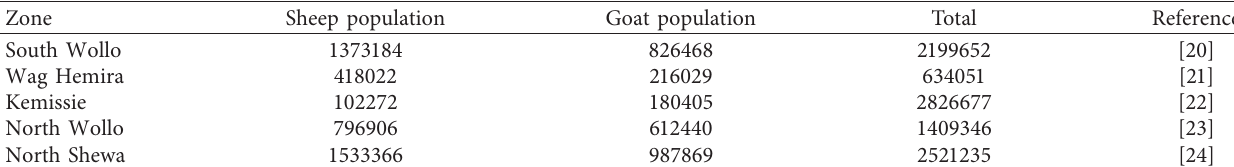
Figure 1: Map of the study zones (produced by using QGIS 2.18.28). Table 1: Sheep and goat population in the study